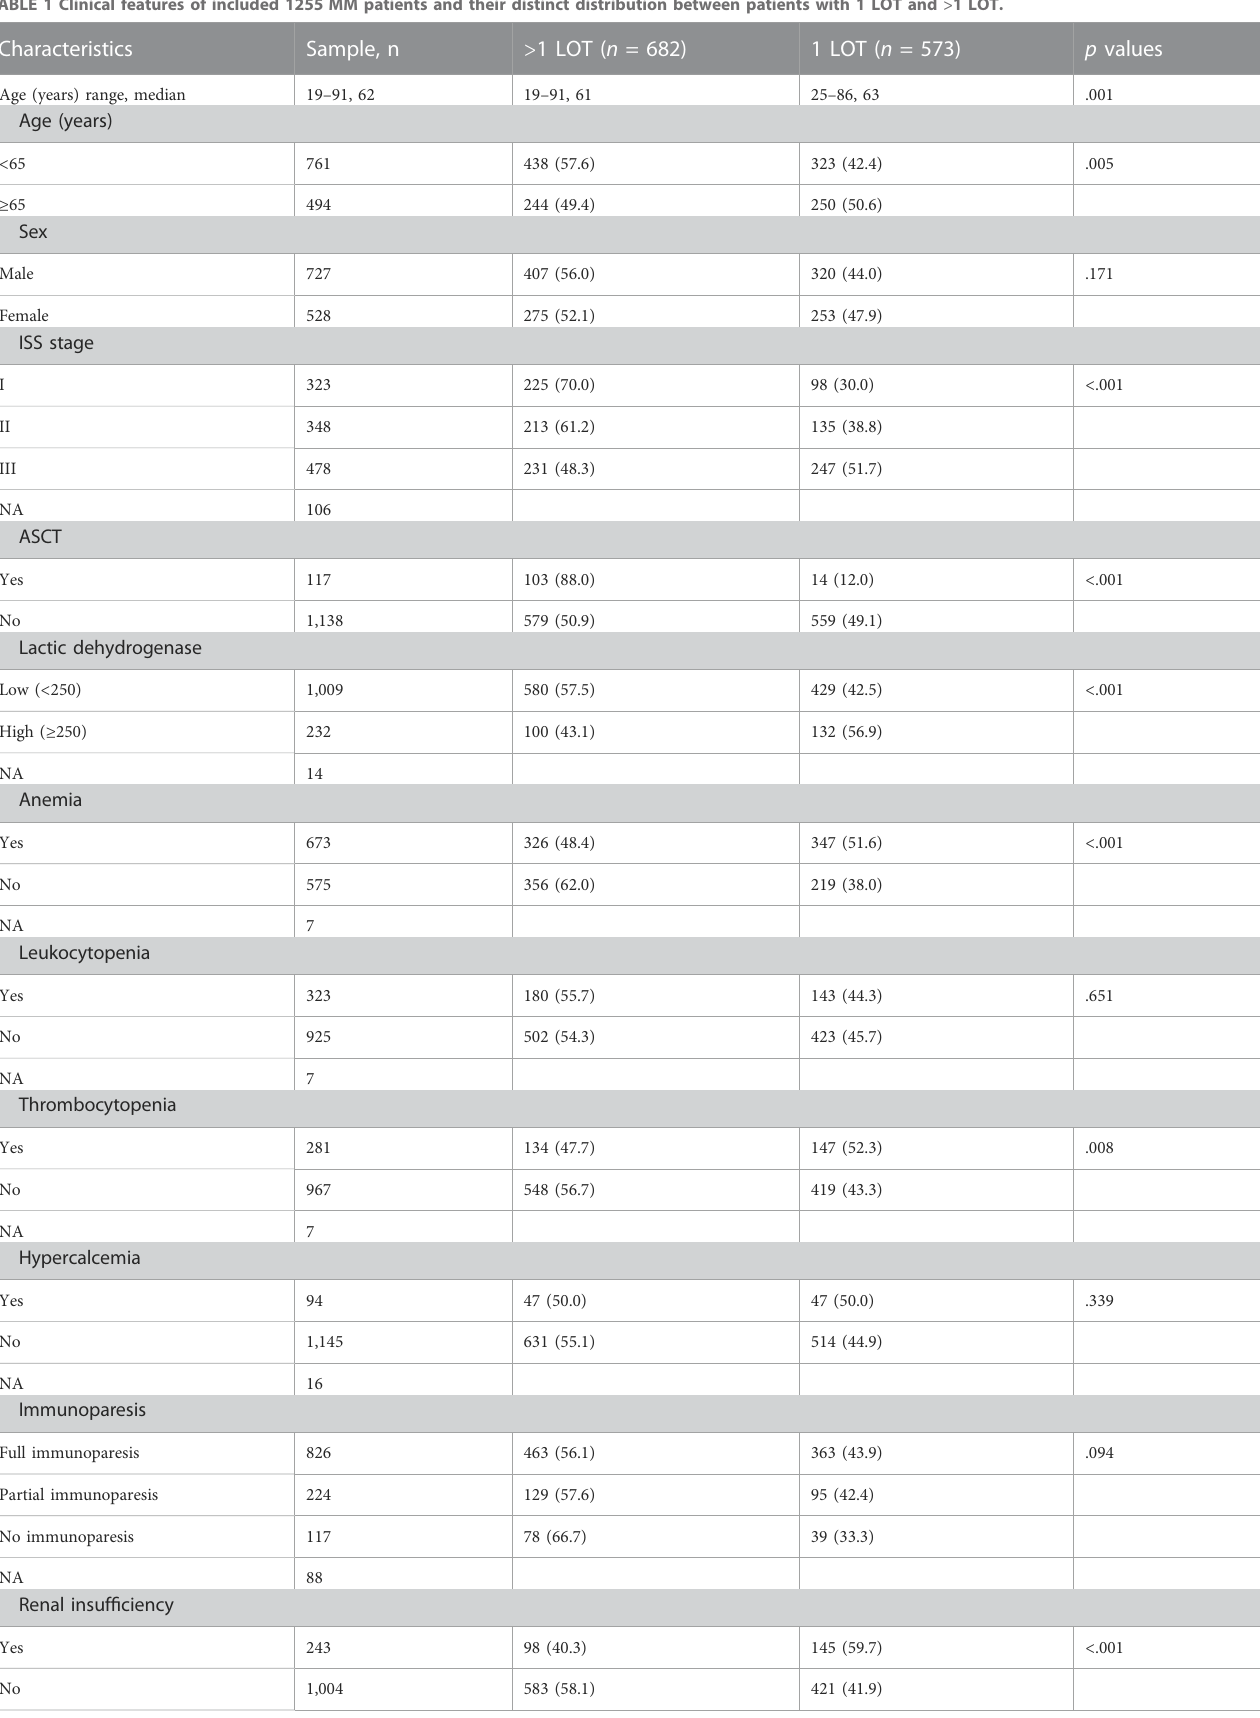
TABLE 1 Clinical features of included 1255 MM patients and their distinct distribution between patients with 1 LOT and > 1 LOT.